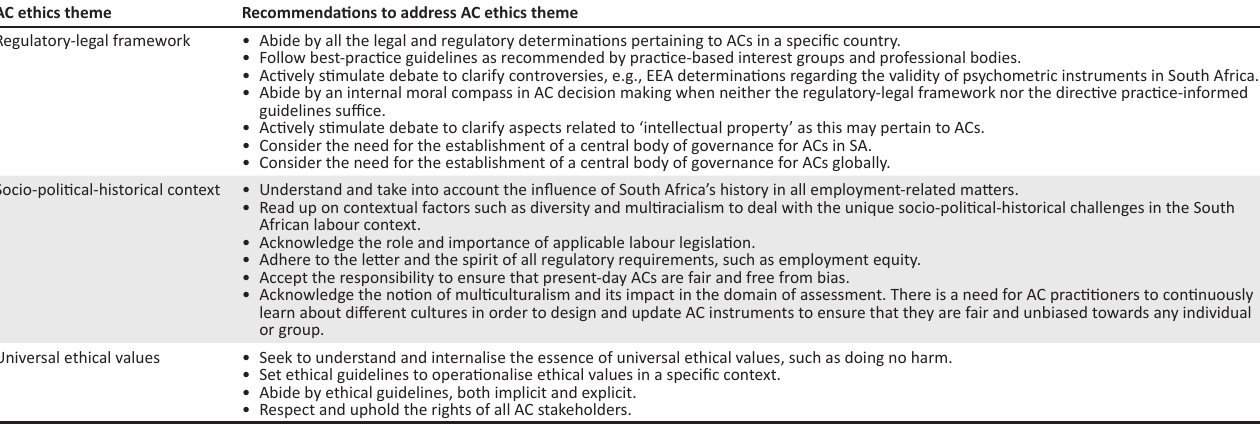
TABLE 1-A3: Recommendations to address ethical challenges in ACs in South Africa (listed in alphabetical order according to an overarching